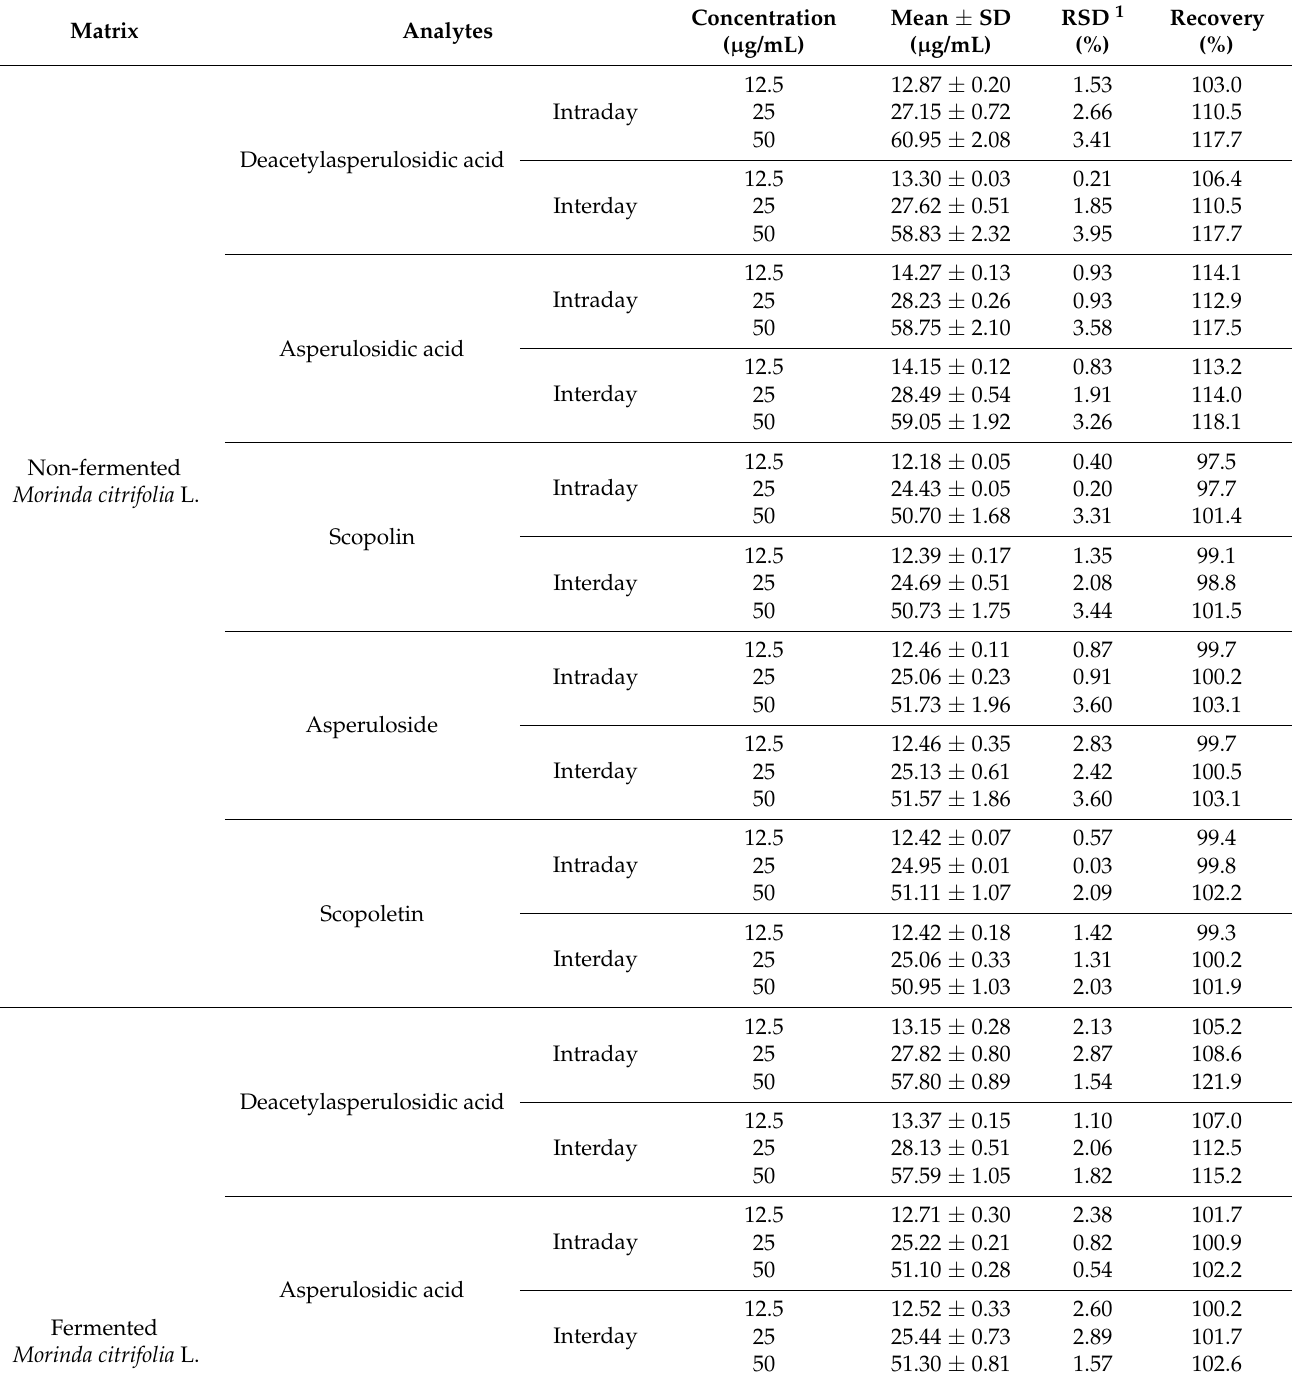
Table 2. Recoveries of bioactive compounds (three different concentrations) in non-fermented and fermented Morinda citrifolia L. extracts.